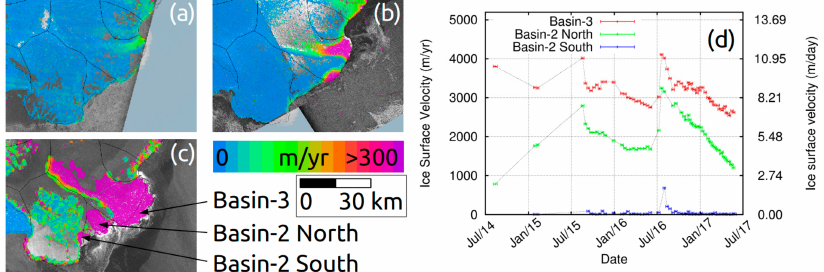
Figure 6. Ice surface velocity maps for the southeastern tip of Austfonna (Svalbard) from JERS-1 SAR data of 1998 ( a ), ALOS-1 PALSAR-1 data of 2010 ( b ) and Sentinel-1 from 26/07/2016 to 07/08/2016 ( c ) and time-series of Sentinel-1 velocity for Basin-3, Basin-2 North and Basin-2 South ( d ). The arrows point to the locations used for the time series.